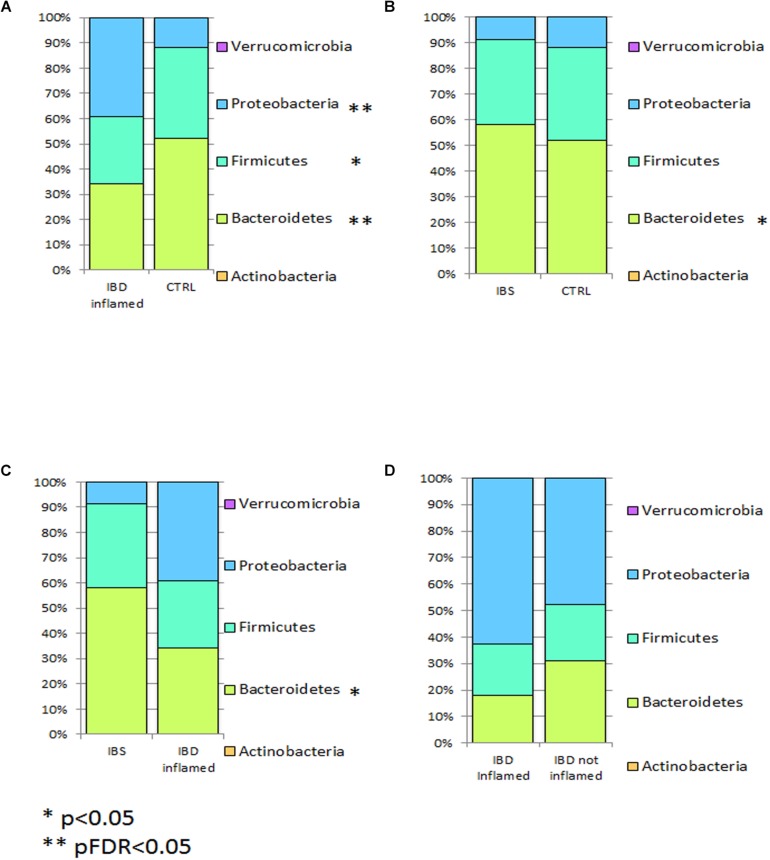
Bar chart reporting Kruskal-Wallis test results on mucosal OTUs grouped at taxonomic level of phylum for IBD vs. CTRL (A), IBS vs. CTRL (B), IBD vs. IBS (C), and IBD inflamed vs. not inflamed (D). Mucosal samples have been grouped and averaged in the comparisons IBD inflamed vs. CTRL (A), IBS vs. CTRL (B), IBD inflamed vs. IBS (C), and IBD inflamed vs. not inflamed (D). Each column in the plot represents a group, and each color in the column represents the percentage of relative abundance for each phyla. p values corrected for FDR were highlighted by star.